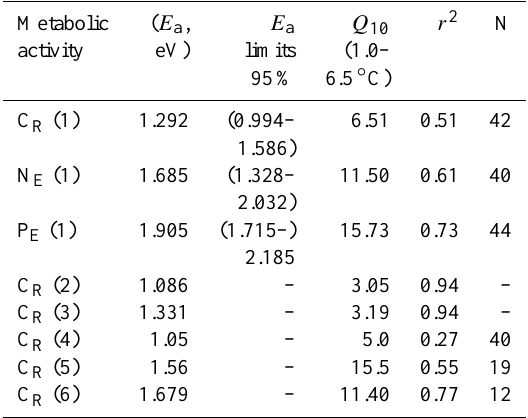
Table 5. Activation energy (eV), Q 10 for the temperature range ex- plored, determination coefficient and number of data correspond- ing to the metabolic processes represented in the plots of Fig. 3, and previous data from other authors: (1): This work (in parenthe- ses the E a limits for the 95% significance). (2): Average values for mixed Arctic and Antarctic zooplankton (euphausiids, amphipods,